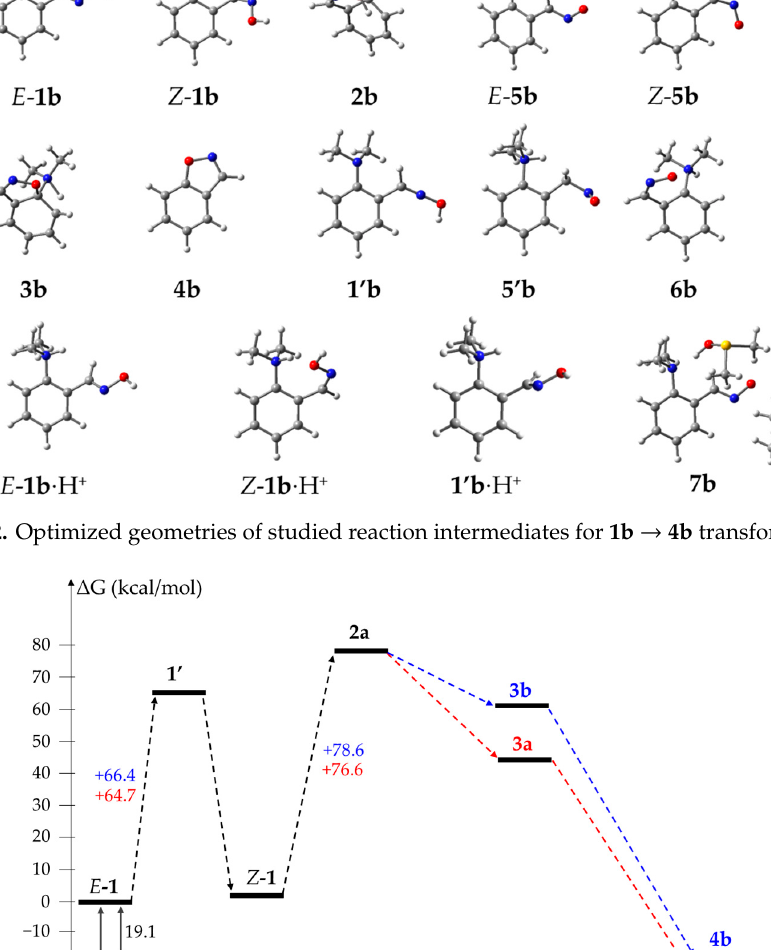
Figure 3. Comparison of reaction profiles for E - 1a → 4a (red) and E - 1b → 4b (blue) via “neutral” path A.